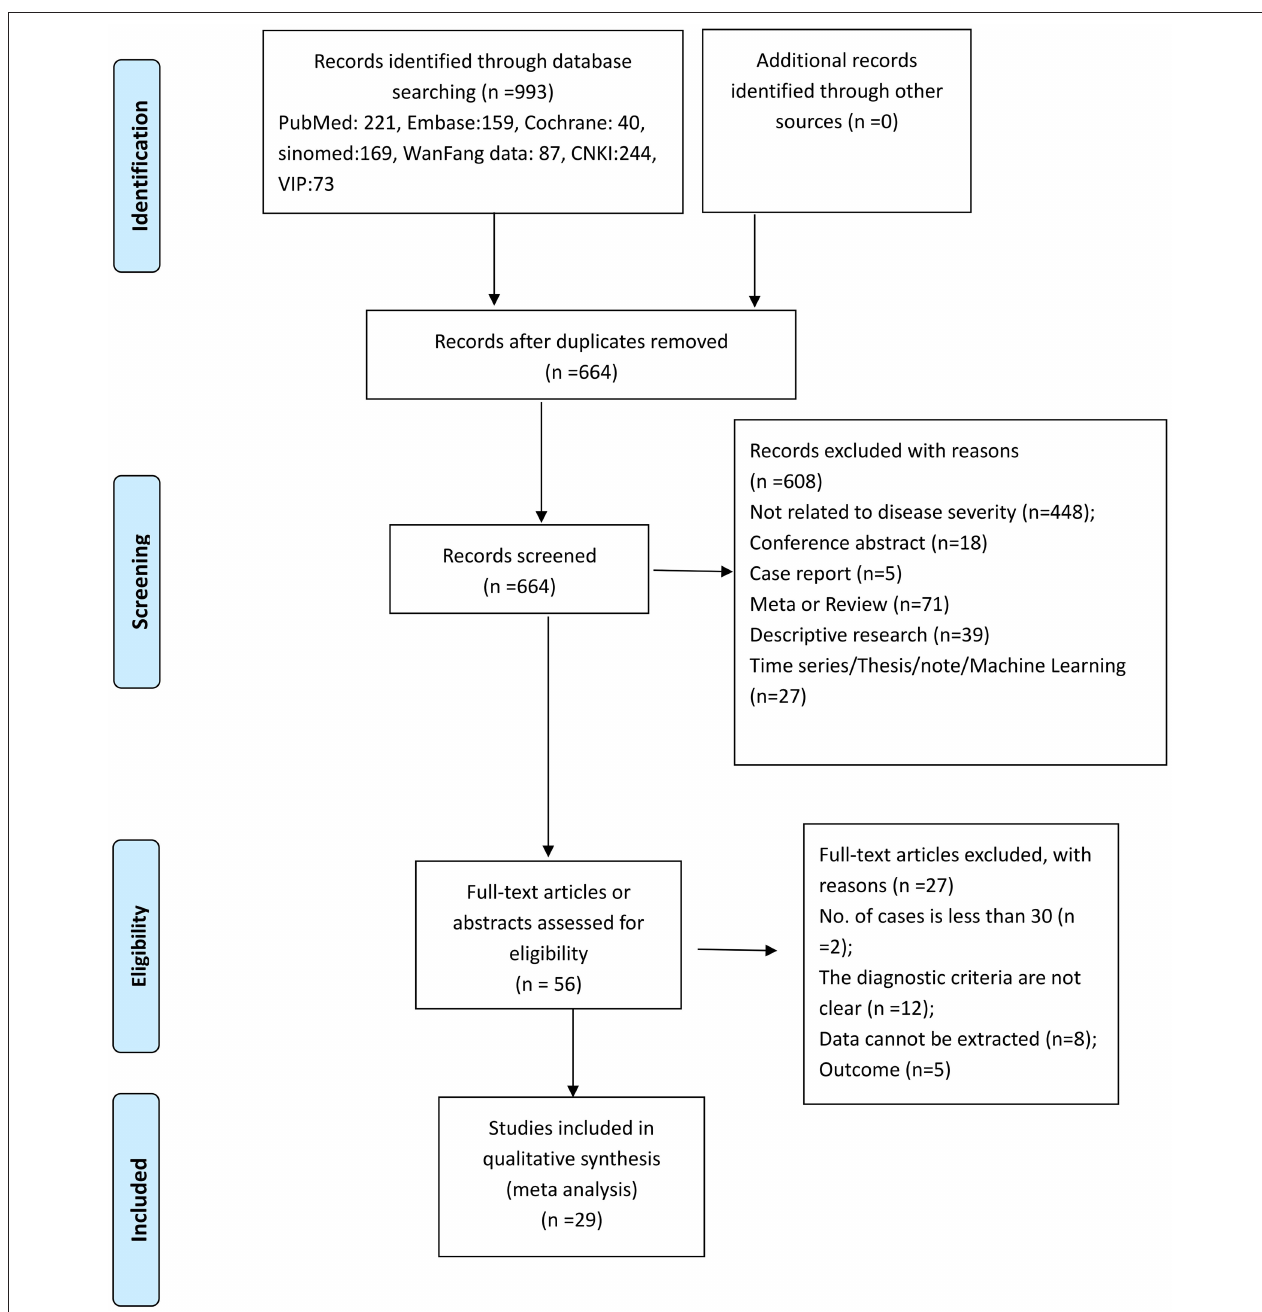
FIGURE 1 | PRISMA 2009 flow diagram of the study selection